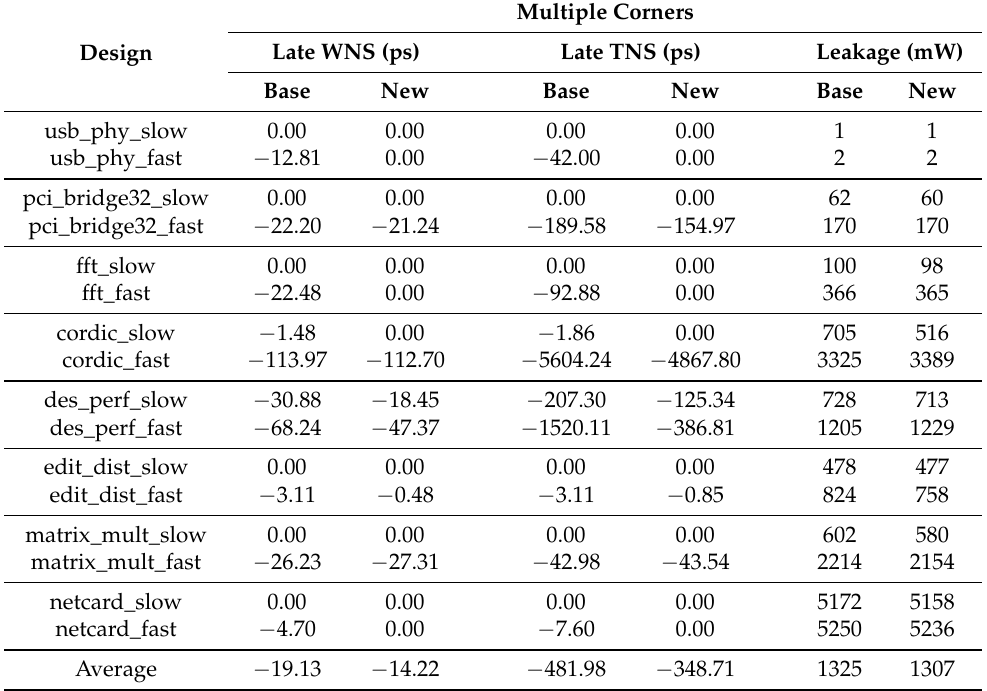
Table 4. Timing and leakage power of all designs under multiple corners with gate size selection restriction without (Base) and with (New) proposed LM